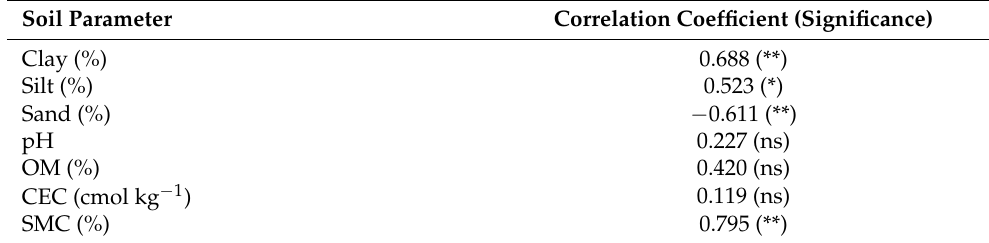
Table 2. Correlation coefficients between soil apparent electrical conductivity (EC a ) and soil parameters of the experimental field (0–0.30 m) on 23 April 2018.